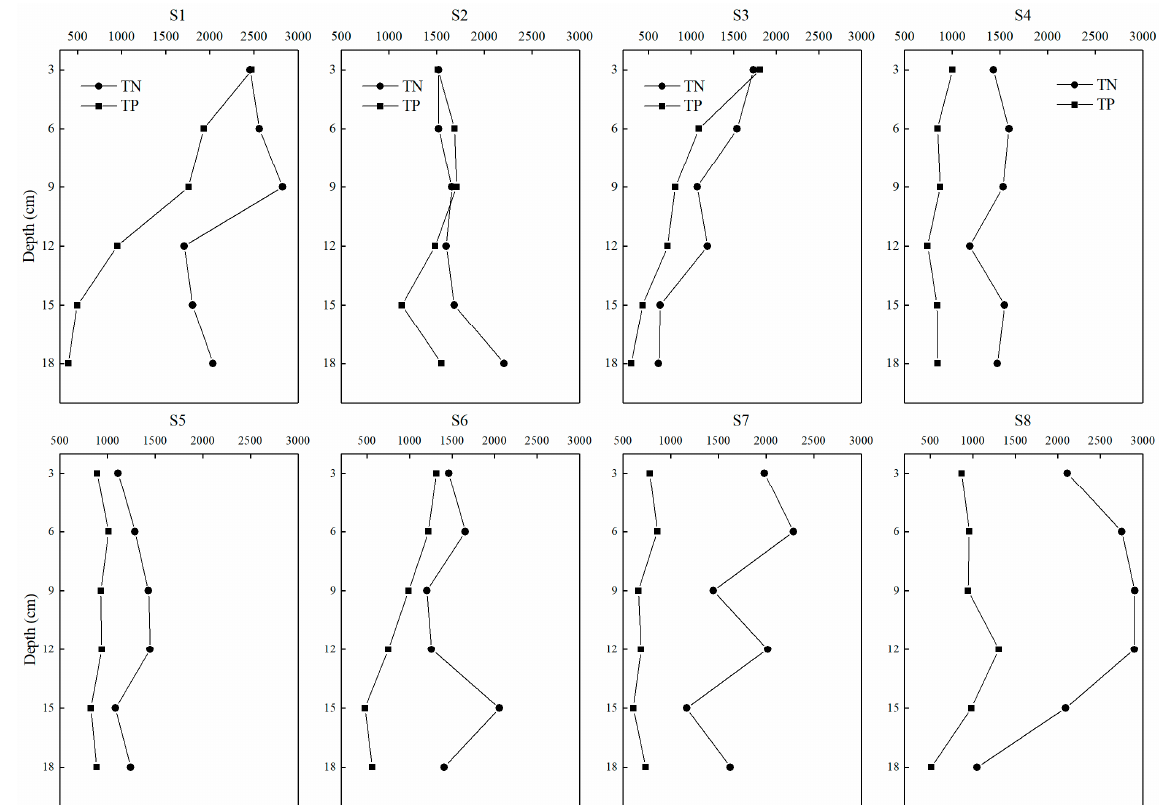
Figure 7. TN and TP concentrations (unit: mg/kg) with depth of the sediment in the eight connected rivers.